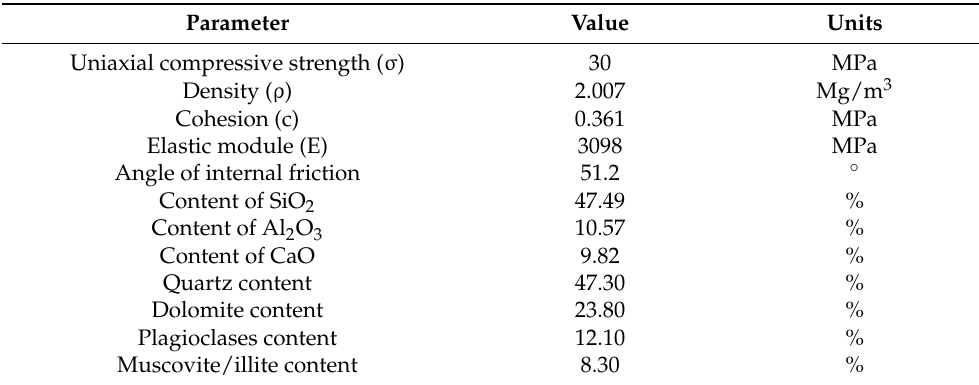
Table 1. Results of the rock investigations (significant variables influencing the wear of the bit materials).